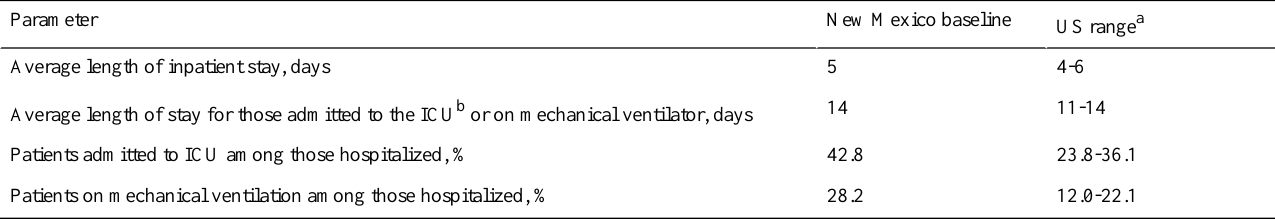
Table 1. New Mexico baseline parameters for COVID-19 health care use needs based on data from March to June